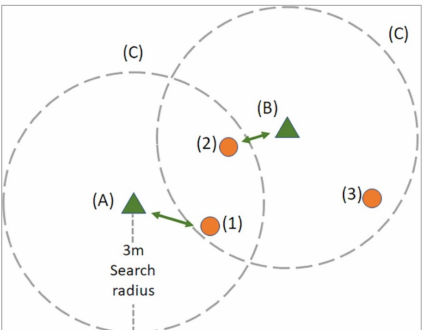
Figure 11. Overview of tree matching process. A 3 m radius (C) was used to generate a table of potential matches between ground-measured reference trees and predicted trees. Reference trees (A and B) each have multiple potential matches with predicted trees (1, 2 and 3). The objective is to match two predicted trees to the reference trees such that the total distance between matched trees is minimized. An optimal solution can be identified via linear integer programming using the TreeMatch software. In this example, reference trees A and B are matched to predicted trees 1 and 2, respectively, while 3 is considered a false positive pending field revisit and review.